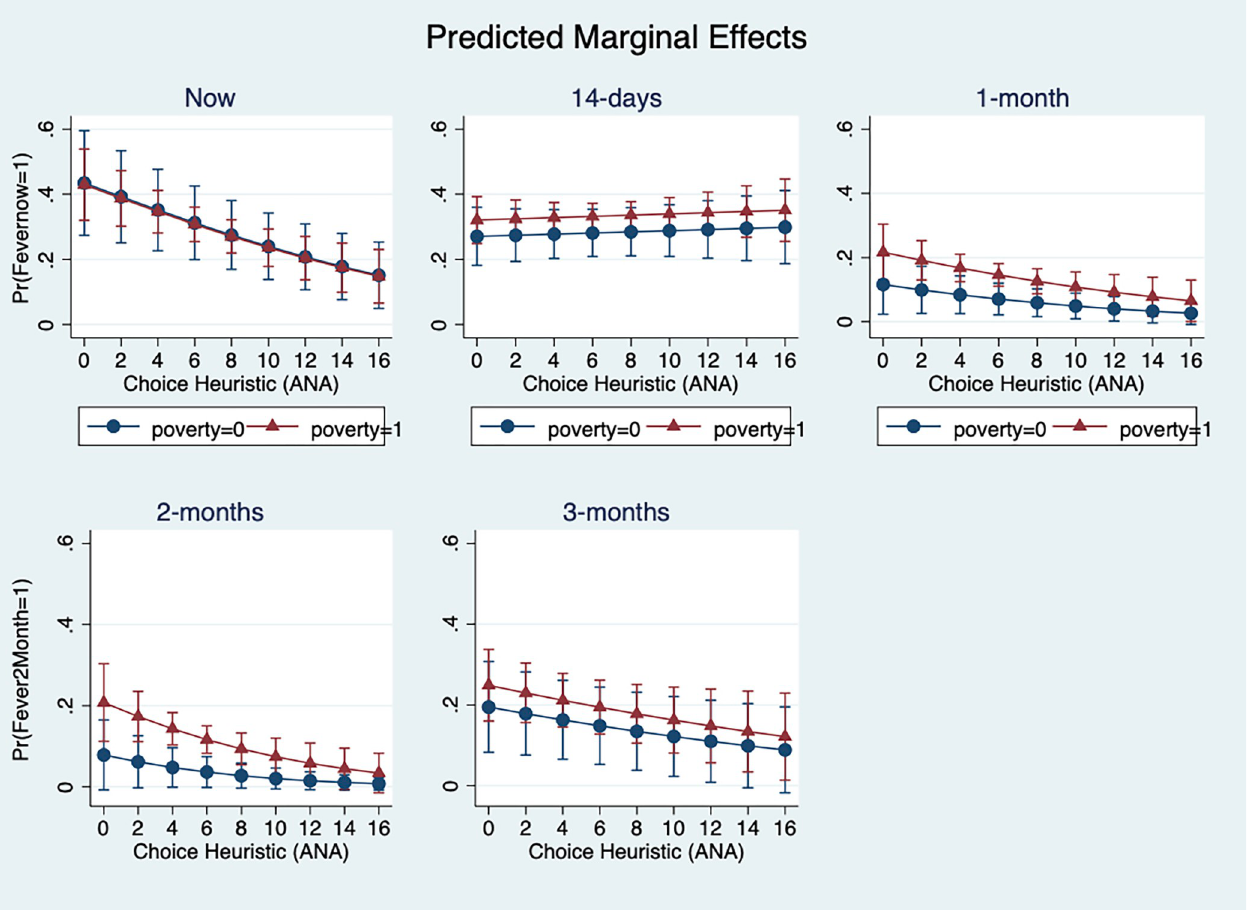
Fig 1. Predictive partial marginal effects of heuristic use (ANA) on fever reporting.